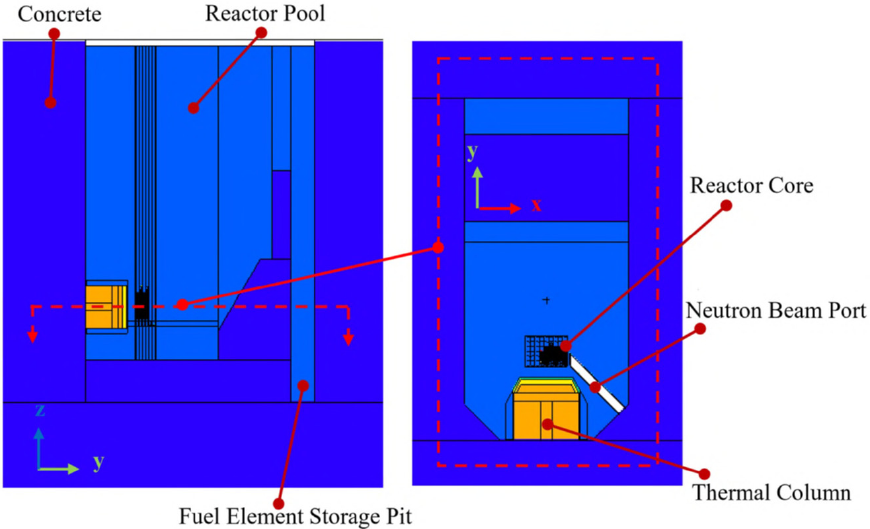
Figure 5. MSTR MCNP6 model (left) ZY side view (right) XY top view. Figure is taken from [13].